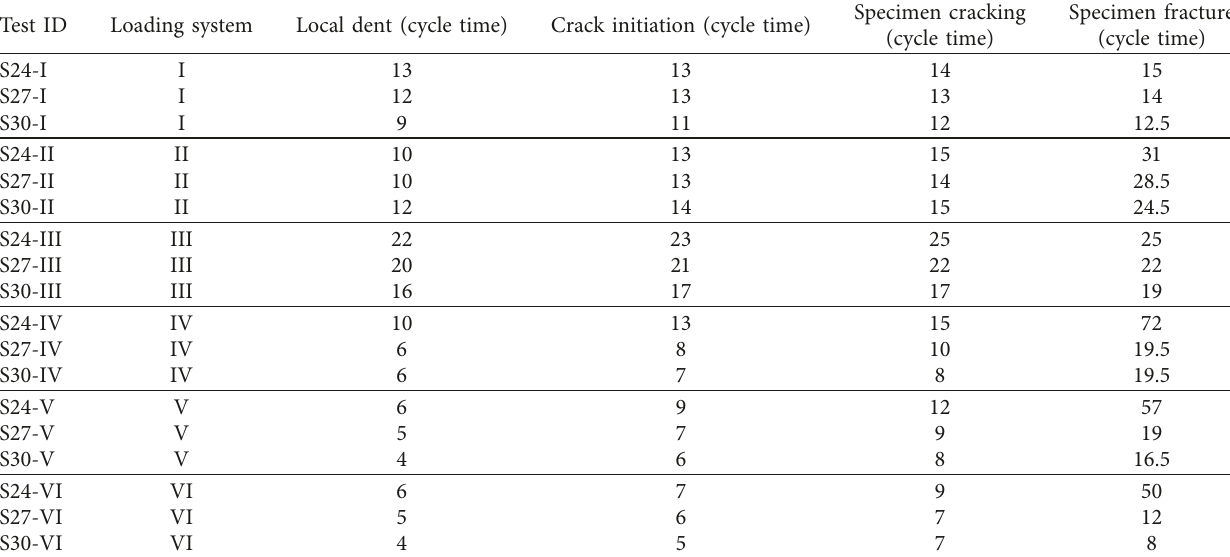
Table 4: Characteristic points of test